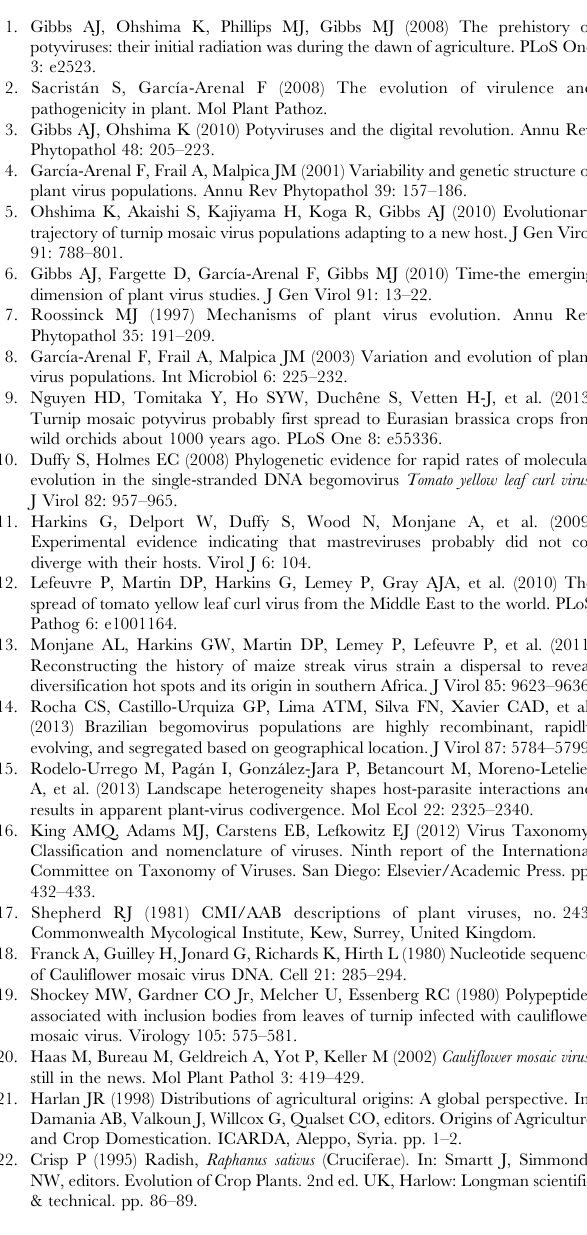
Table S1. Cauliflower mosaic virus isolates analyzed in this study. (DOC). Table S2. Detailed results from BEAST analyses of Cauliflower mosaic virus